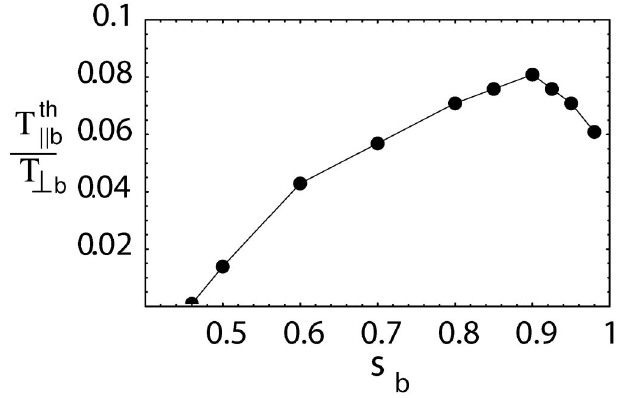
FIG. 1. Longitudinal threshold temperature T th to the transverse temperature T ? static Harris instability plotted versus normalized beam inten- (cid:7) ^ ! 2 = 2 ! 2 . sity s b pb f